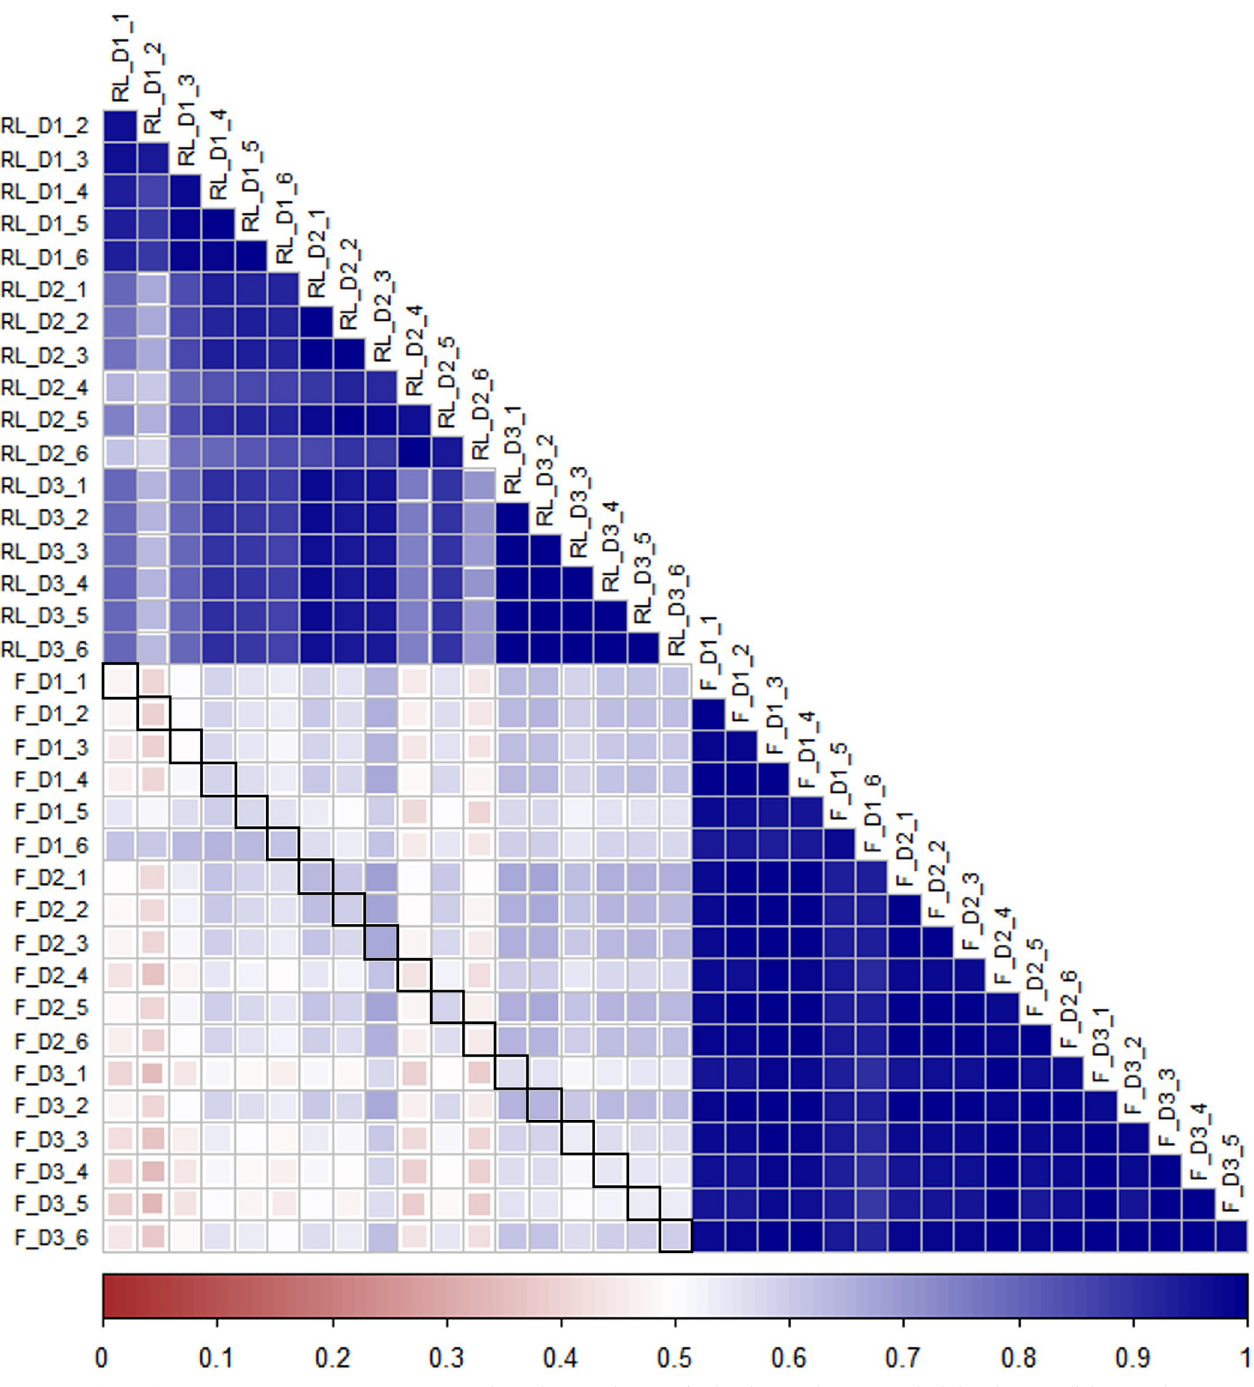
Fig 5. Correlation heatmap representing correlations. Correlation heatmap between fecal and rumen liquor microbial abundance in all the animals. F = fecal, RL = rumen liquor, D = Diet and numbers 1 to 6 represent the individual animals. Fecal -rumen liquor pairs from the same animal are highlighted by a black square. Overall comparison between fecal and rumen liquor sample types was not significant p = 0.91.